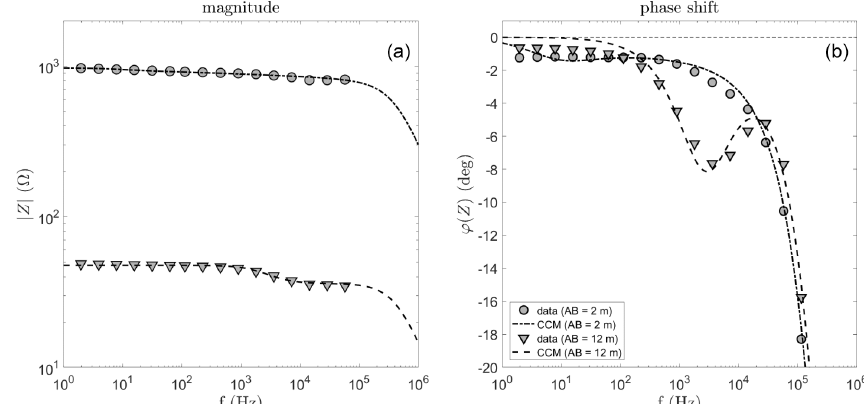
Figure 7. Spectra of the magnitude (a) and the phase shift (b) of the impedance Z for two measurements with electrode spacing AB = 2m (dots) and AB = 12m (triangles). The larger spacing, associated with higher investigation depth, shows a distinct frequency peak above 1kHz, whereas the other spacing shows weaker frequency dependence. The symbols indicate the measured data; the dashed lines are the data calculated for the single Cole-Cole model, the parameters of which are provided in Table 1.